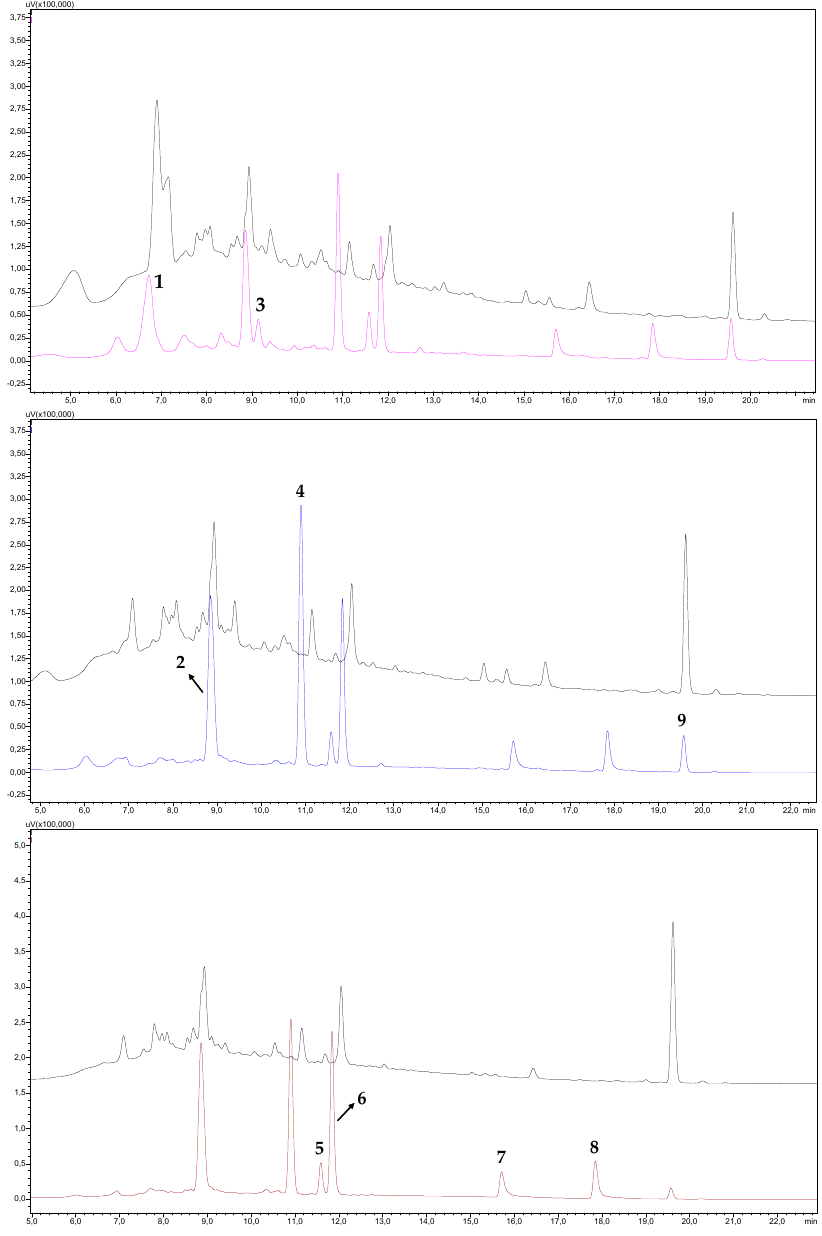
Figure 2. Chromatogram of the selectivity test, obtained by HPLC-DAD, containing one of the analyzed craft beer samples (Black line) and the same sample added with a standard solution of phenolic compounds (12.5 mg L − 1 ) (pink = 280 nm; blue = 300 nm; and brown = 320 nm). Identification of the peaks: 1. catechin; 2. caffeic acid; 3. epicatechin; 4. p -coumaric acid; 5. hydrated rutin; 6. trans -ferulic acid; 7. quercetin; 8. kaempferol; 9. formononetin.